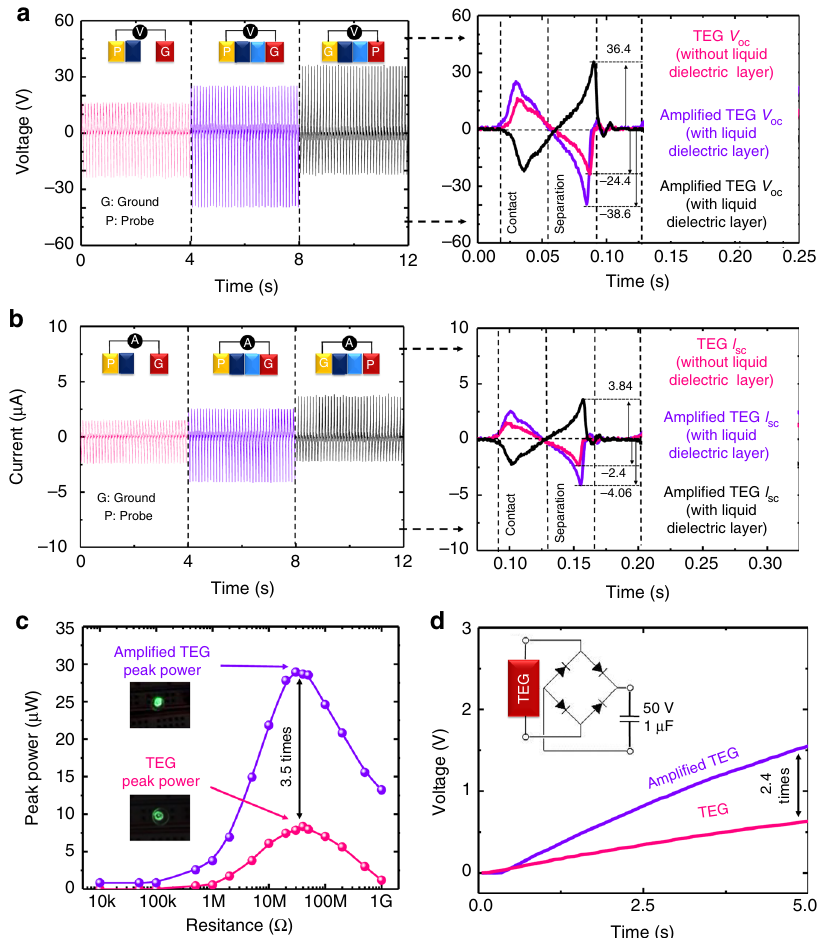
Fig. 4 Effects of ELRG are demonstrated through a triboelectric generator for experimental validation. All electric performances are measured under a 9 Hz TEG. a Comparative analysis of open-circuit voltage ( V oc ). Open-circuit voltage without ELRG (pink lines); with ELRG (both purple and black lines). b Comparative analysis of short-circuit current ( I sc ). Short-circuit current without ELRG (pink lines); with ELRG (both purple and black lines). c Peak power performance of TEG under load resistances. Inset pictures show that TEG power with ELRG lighten an LED more brightly. d Capacitor charging performances of